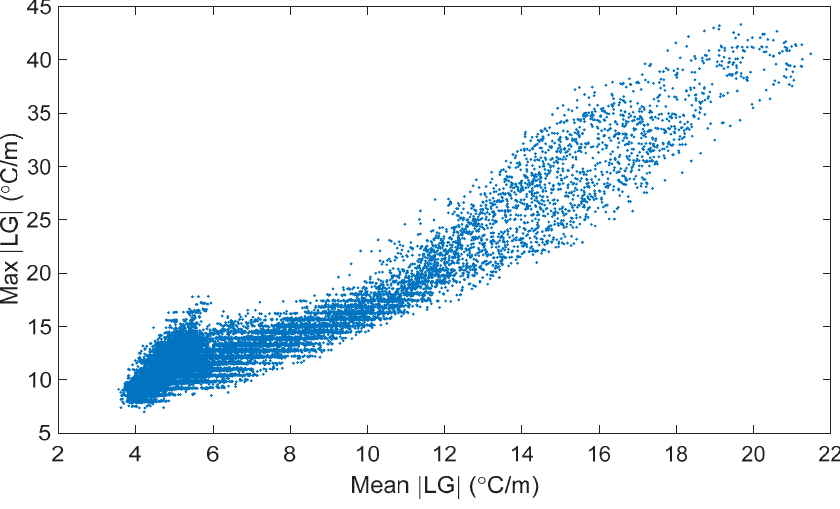
Figure 12. Maximum vs. mean absolute local thermal gradient.